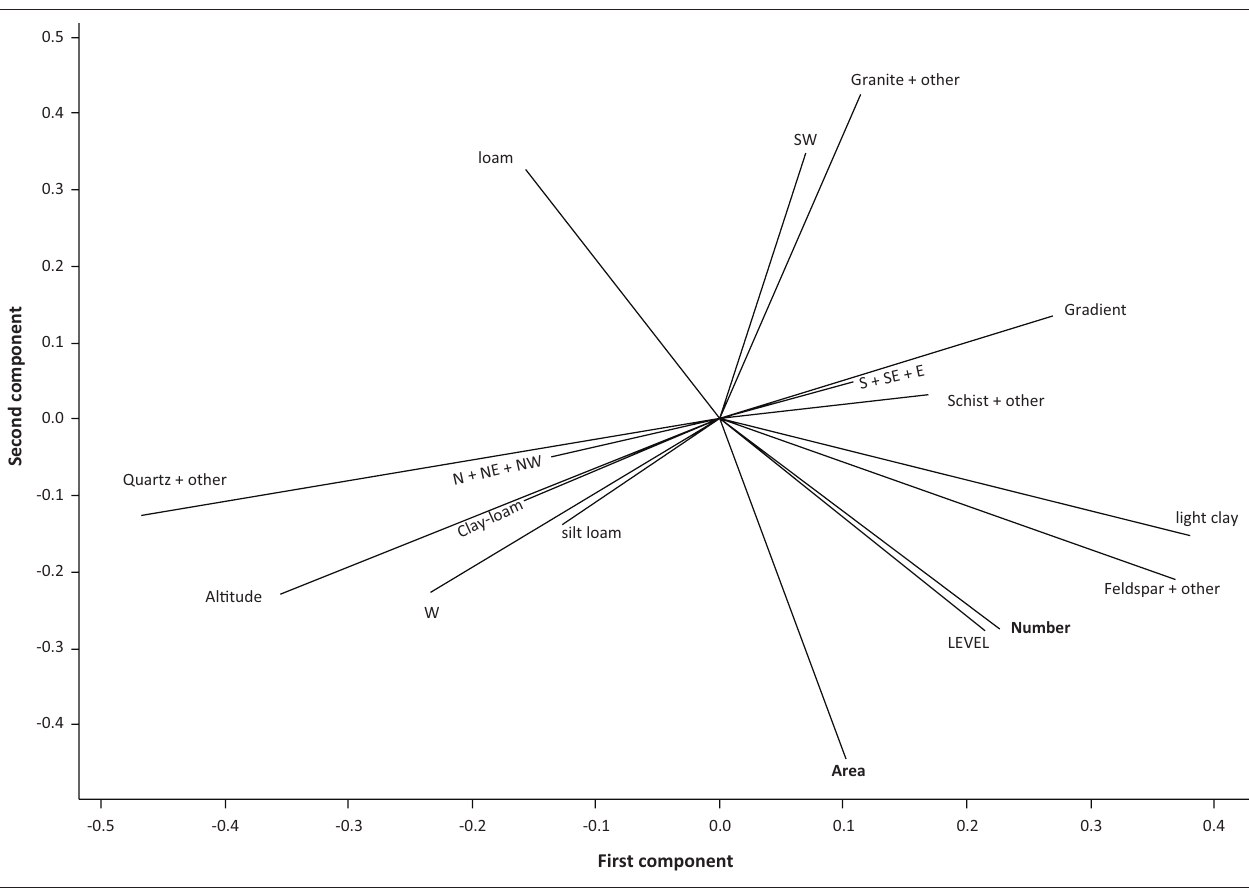
FIGURE 3: Principal component analysis showing the relationship between number of plants (Number), occupied area (Area) and habitat parameters: altitude, aspect (N+NE+NW, SW, S+SE+E, LEVEL), gradient (degree of slope), soil texture (loam, light clay, silt loam, clay loam) and substrate (Quartz + other, Granite + other, Schist + other, Feldspar + other) in the 51 sites at Rössing Uranium Limited.